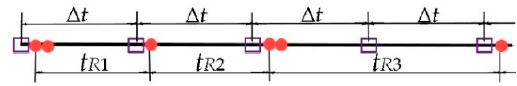
Figure 8. Schematic diagram of the laser’s emission and reception time.